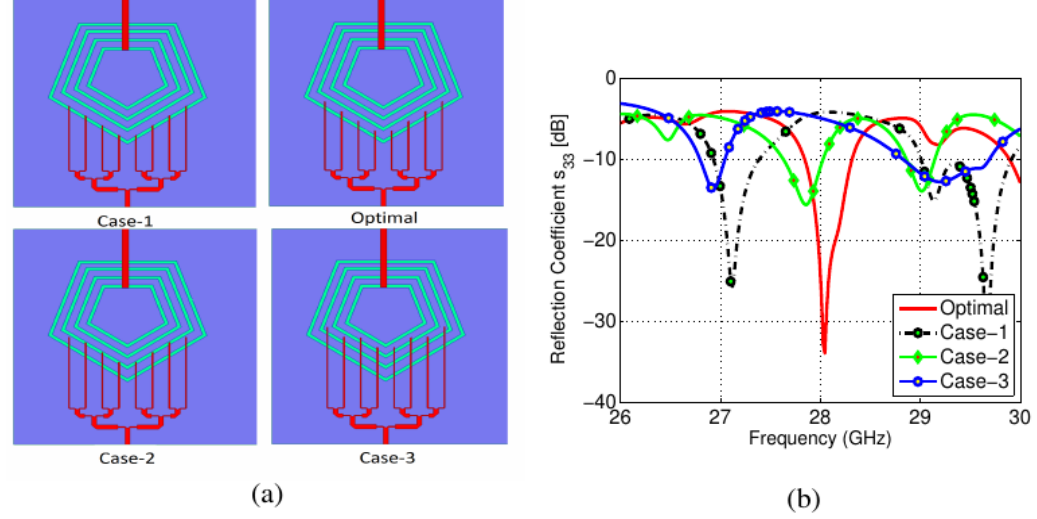
Figure 7. Effects of PD branch lengths: ( a ) Case-1: offset = − 1 mm, Optimal case: optimal offset = 0, Case-2: offset = 2 mm, Case-3: offset = 4 mm; ( b ) S 11 for all given cases.